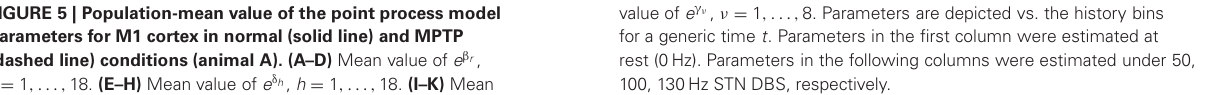
and higher values of the Poisson factor in S1 vs. M1 cortex, both at rest and during